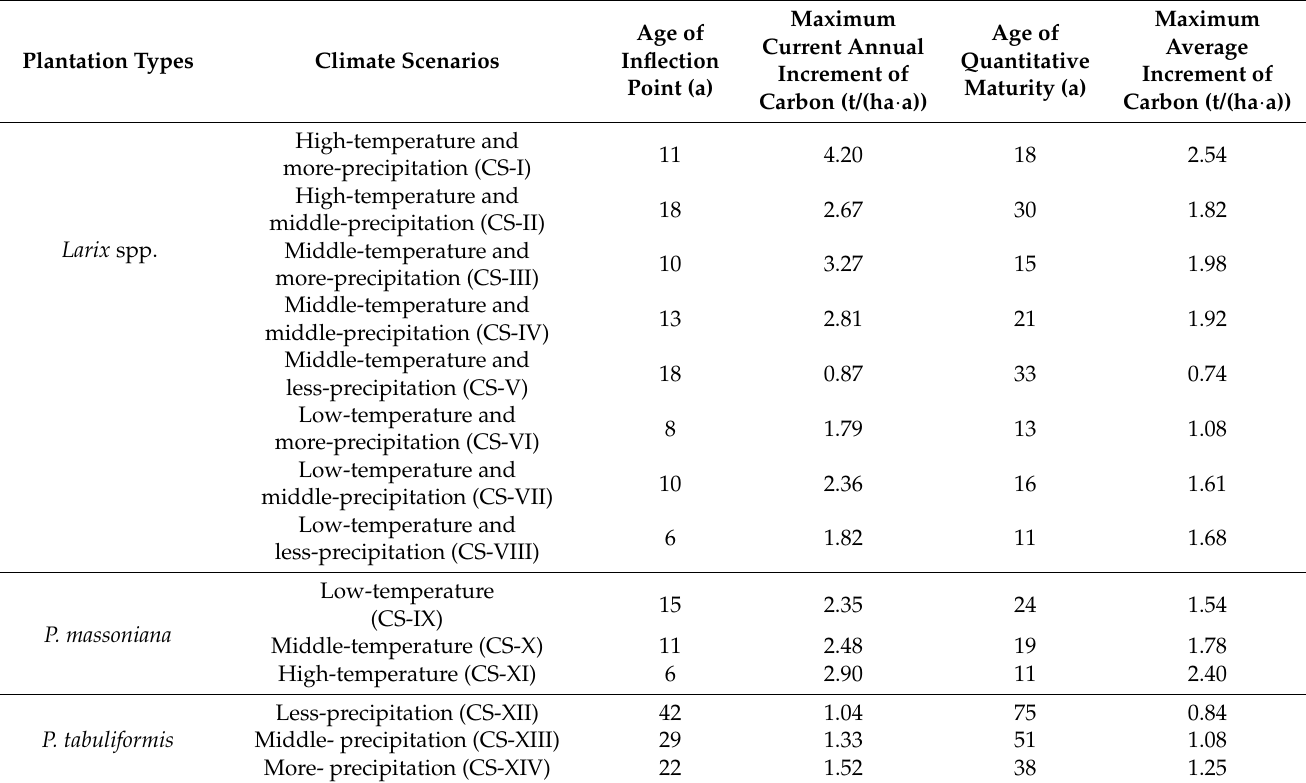
Table 7. Comparison of carbon growth characteristics of different climate scenarios for three planta- tion